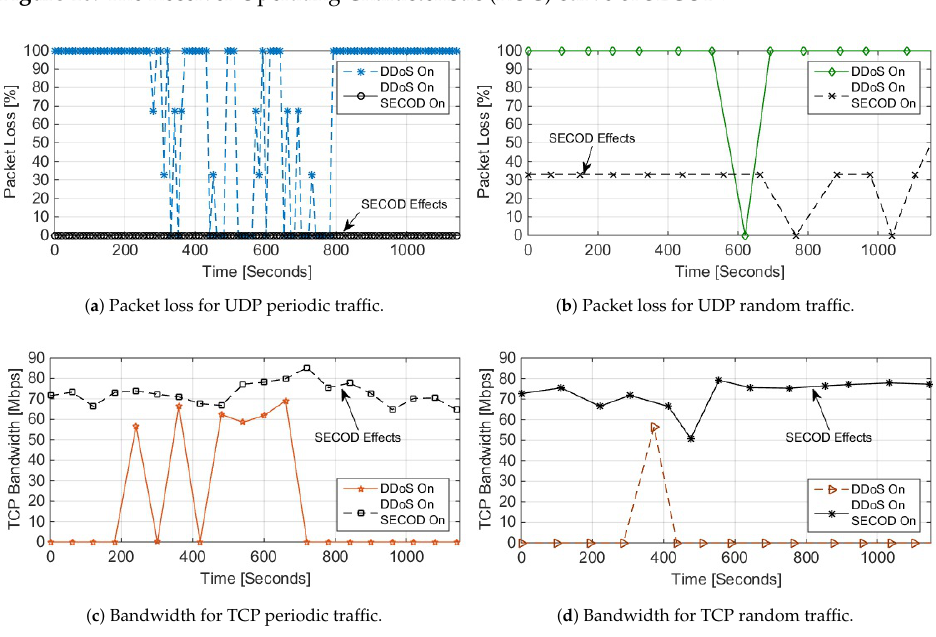
Figure 11. Performance of SDN-based IoT network under DDoS attack conditions with SECOD activated to detect and resist DDoS